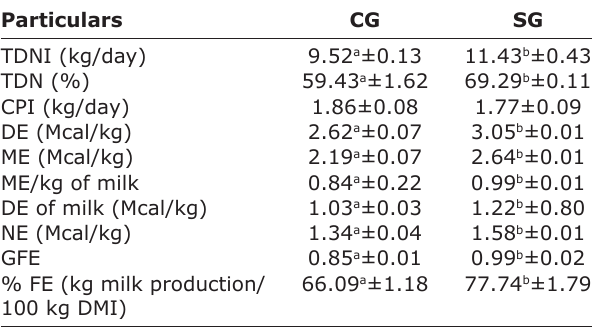
Table-5: Energy intake of feed and milk energy balance in control and prilled fat supplemented buffaloes. Particulars